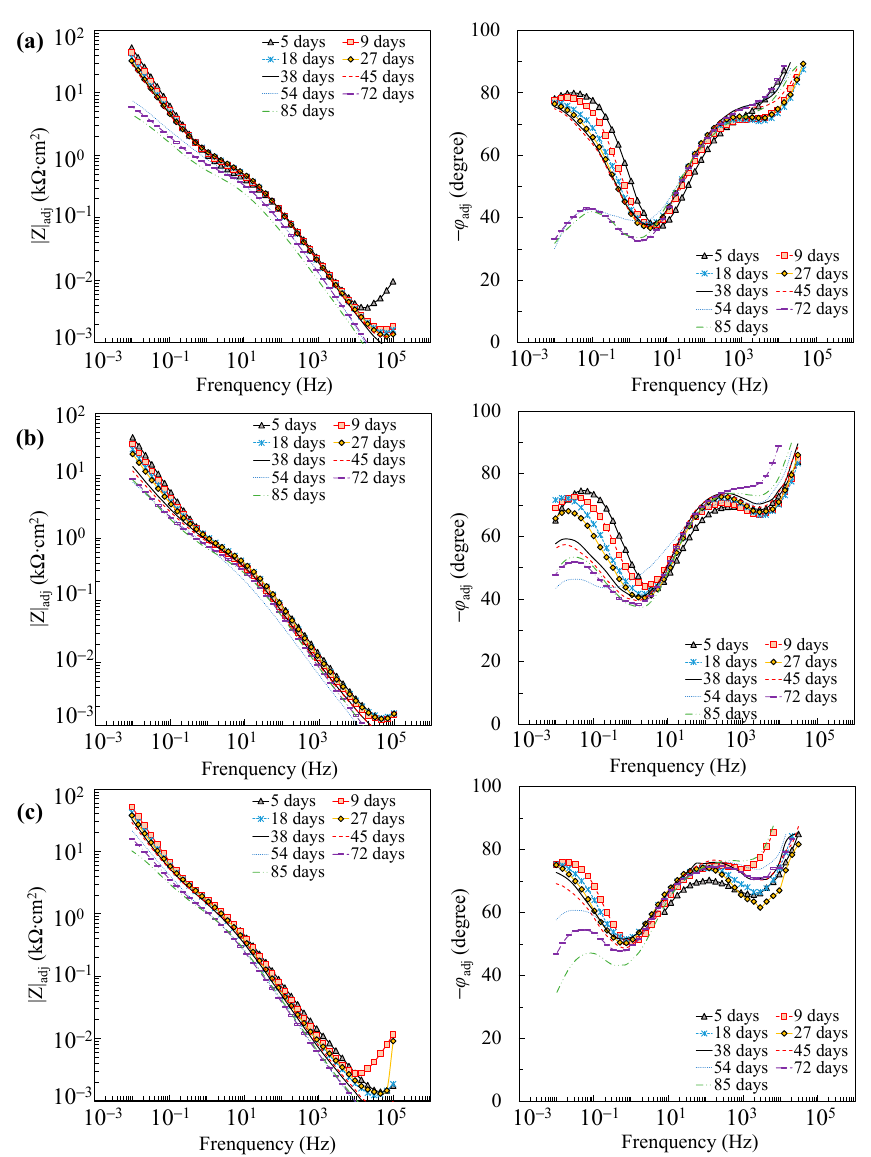
Figure 9. Adjusted Bode plots of the tensile-stressed specimens in coupled cells: ( a ) C3; ( b ) C5; ( c ) C10.